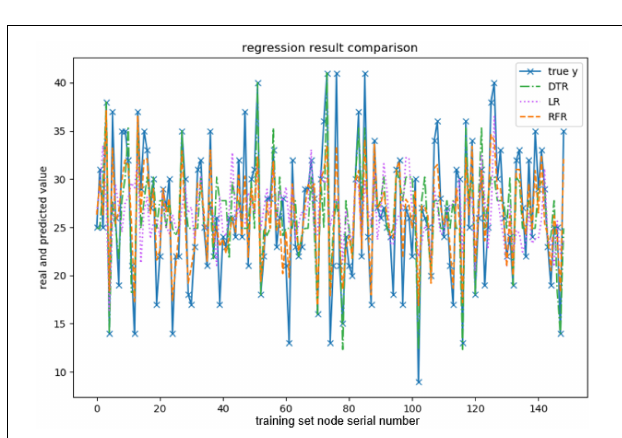
FIGURE 5 | Comparison of extraversion-predicted